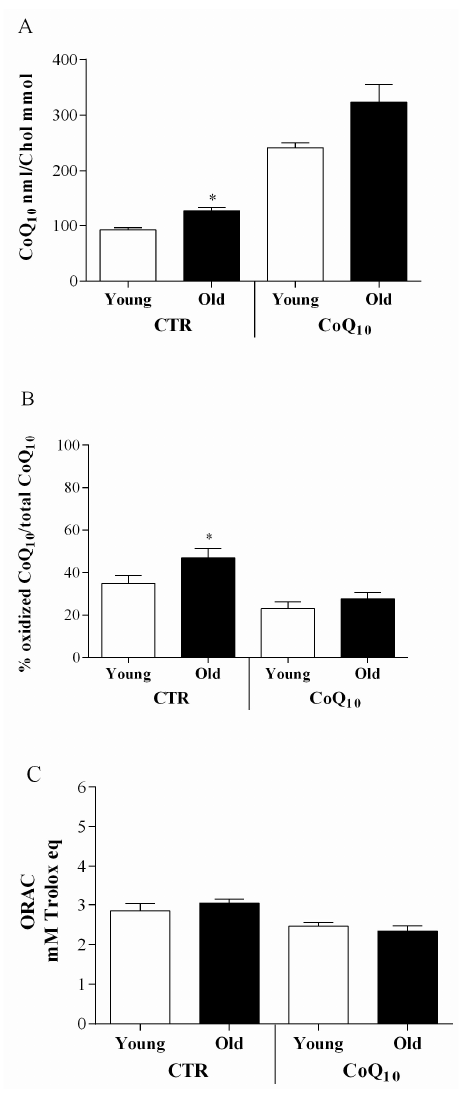
Figure 4. Age related comparison of CoQ10 concentration expressed as nmol CoQ10/mmol Chol ( A ) and oxidative parameters such as % of oxidized CoQ10/total CoQ10 ( B ) and ORAC mMTrolox equivalents ( C ) values, in untreated (CTR) and supplemented (CoQ10) IVF patients below 35 years (Young) or above 35 years (Old). * p < 0.05.